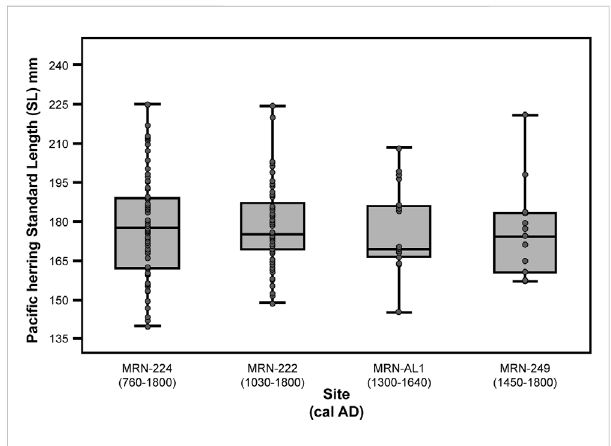
FIGURE 5 Box and whisker plot of Point Reyes Paci fi c herring standard length based on the atlas and axis vertebral width measurements. Archaeological data presented chronologically with radiocarbon date ranges from Sanchez